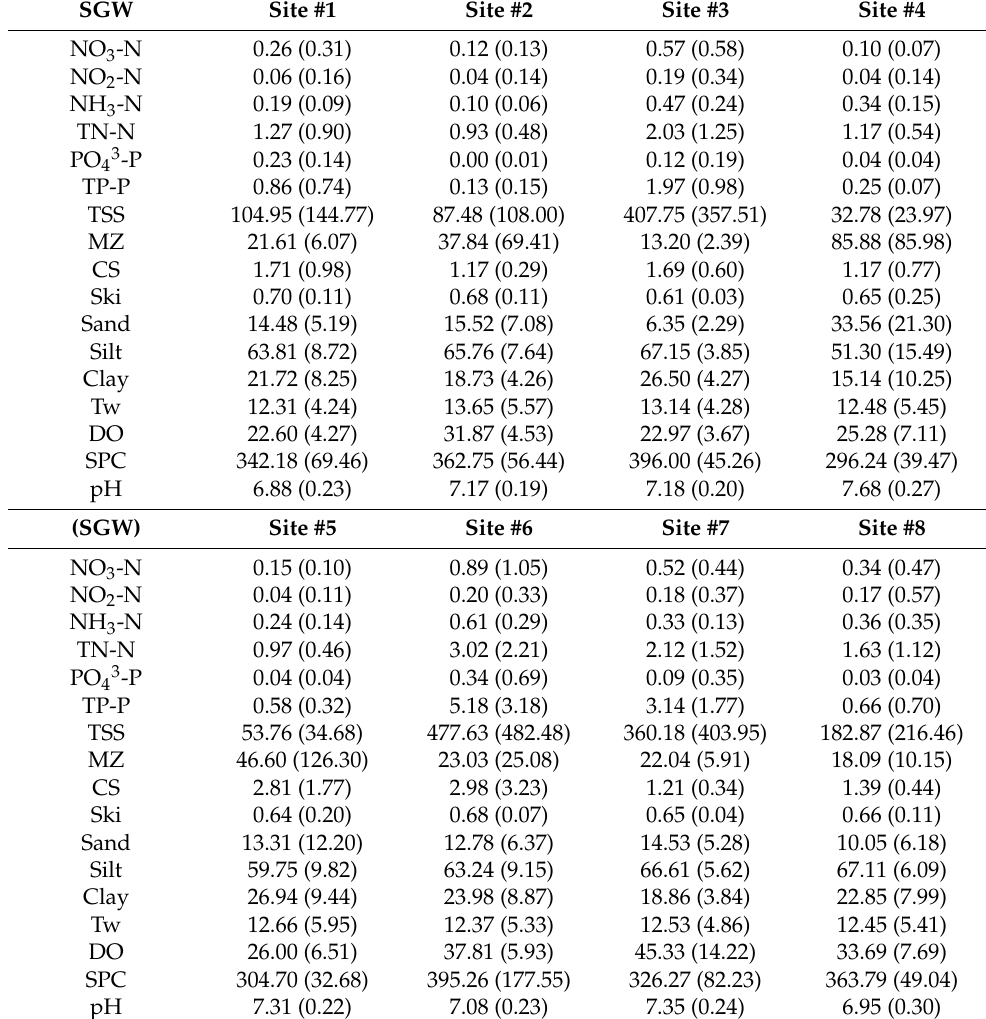
Table 3. Average values (with standard deviations in parentheses) for nutrient concentrations (mg L − 1 ), suspended sediment characteristics [total suspended solids; TSS (mg L − 1 ), mean particle size; MZ ( µ m), calculated surface area; CS (m 2 mL − 1 ), skewness; Ski, Sand (%), Silt (%), and Clay (%)], and physicochemical variables [water temperature (Tw; ◦ C), dissolved oxygen (DO;% saturation), specific conductance (SPC; µ s cm − 1 ), and pH] of shallow groundwater (SGW) during the study period (January 2020–December 2021) for eight monitoring sites in Moore’s Run, Watershed, WV,